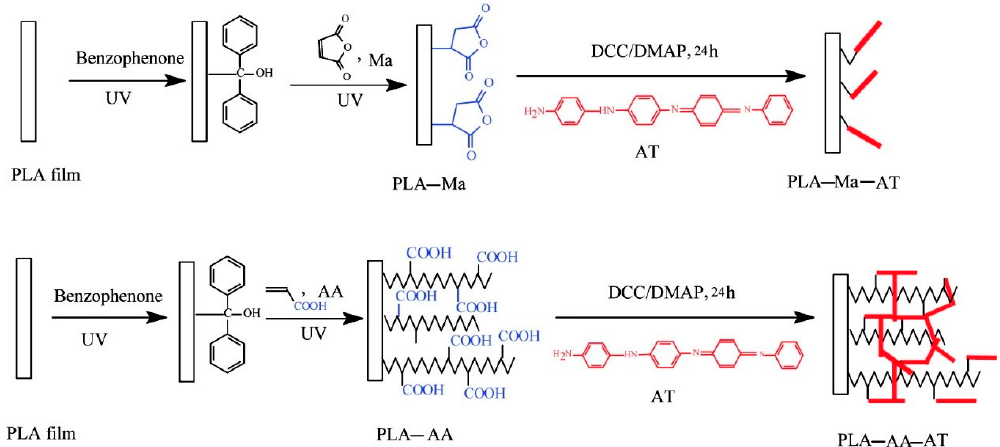
Figure 10. Photografting of poly(lactic acid) (PLA) films with maleic anhydride (MA) (top) and acrylic acid (AA) (bottom), followed by subsequent coupling reactions. Adapted with permission from [142]. Copyright 2012 American Chemical Society.